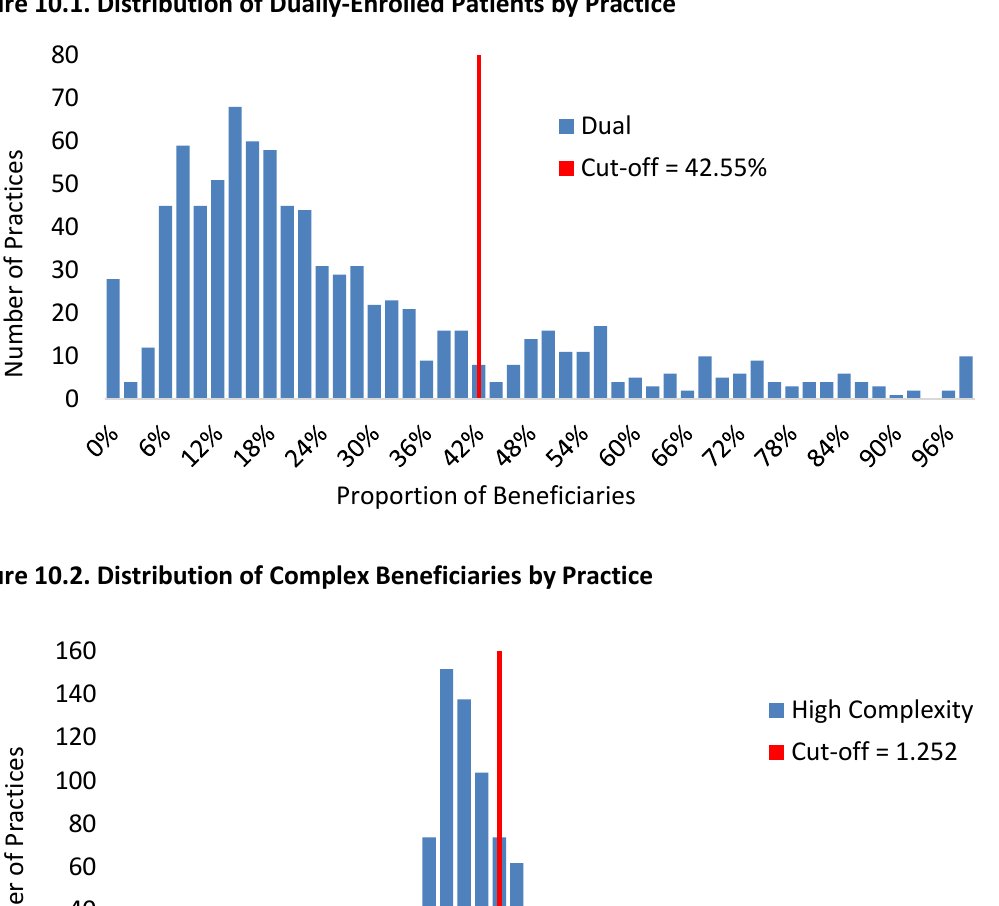
Figure 10.1. Distribution of Dually-Enrolled Patients by Practice